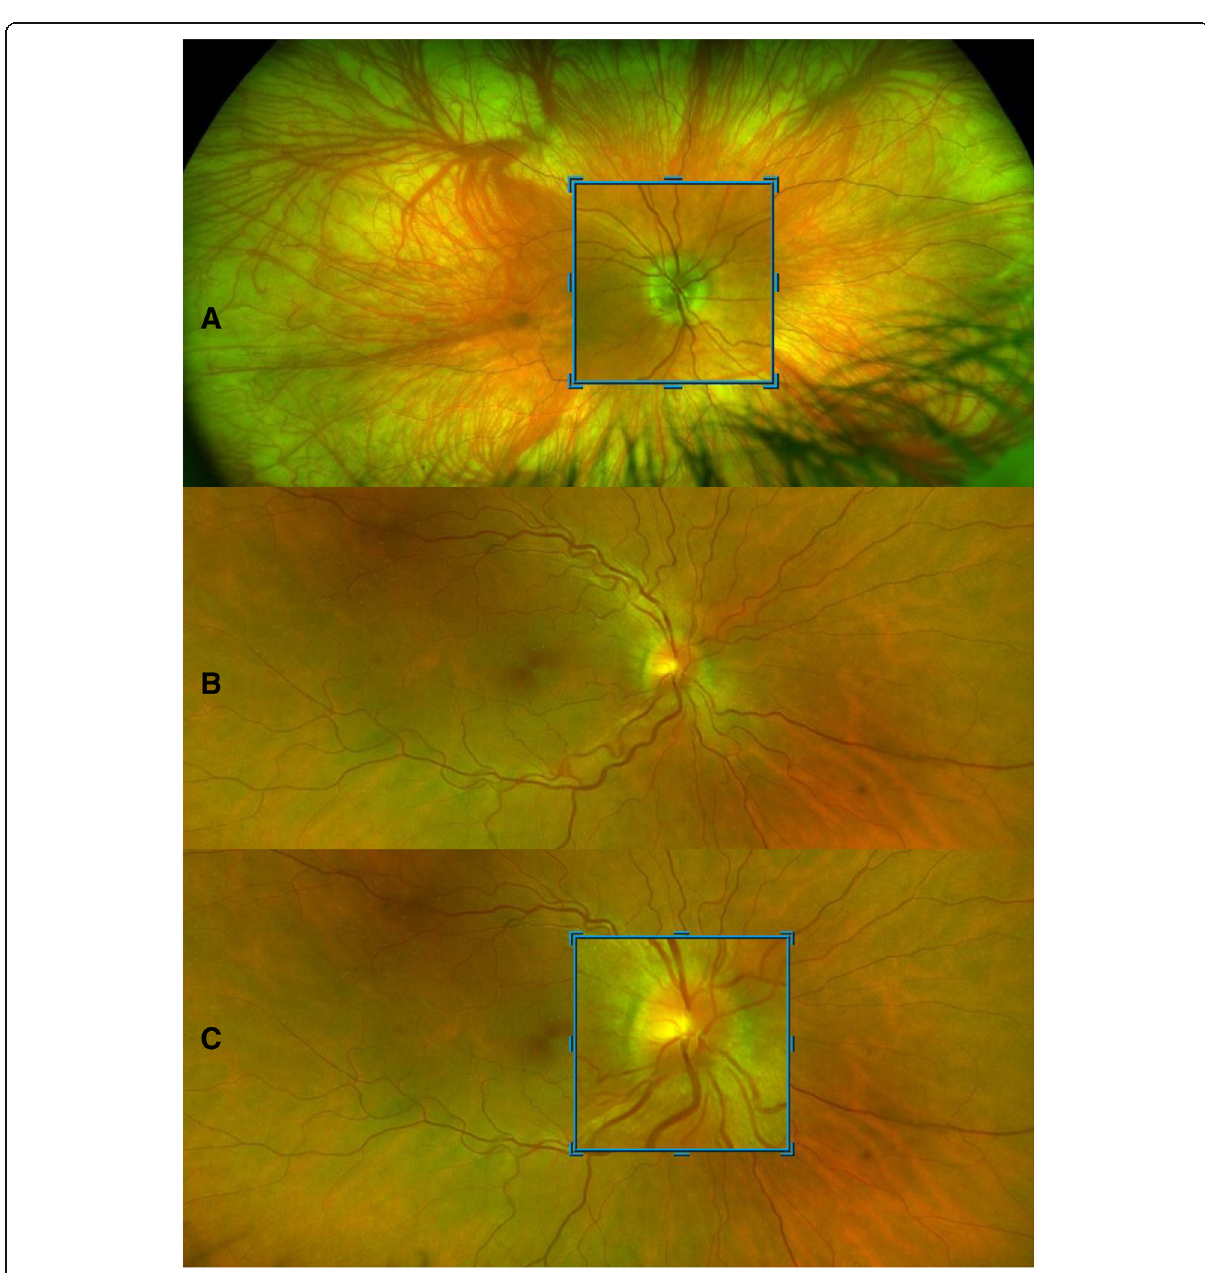
Fig. 3 Wide-field imaging using. Wide-field imaging with the Optos ™ through an undilated pupil in a , normal patient and b , a patient with IIH. a , normal fundus with blue high magnification box to inspect the optic nerve. Peripapillary atrophy 360 o around the disc which is normal. Note the lashes seen inferiorly as artefact on image. b , right optic nerve which has grade 2 Frisen swelling where there is elevation of the optic disc margin 360 o , loss of the clear optic disc margin as seen in a . c , the high magnification tool allows excellent visualisation of the swelling without